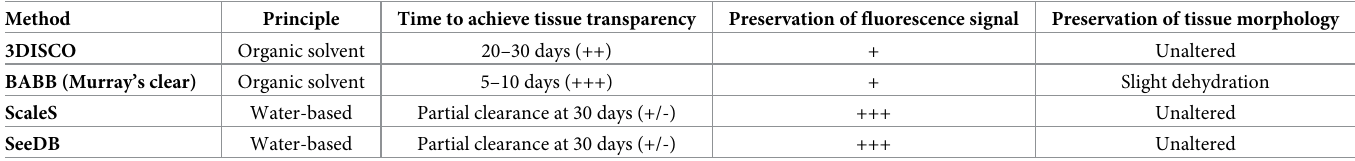
Table 1. Comparison of clearing methods for mosquito